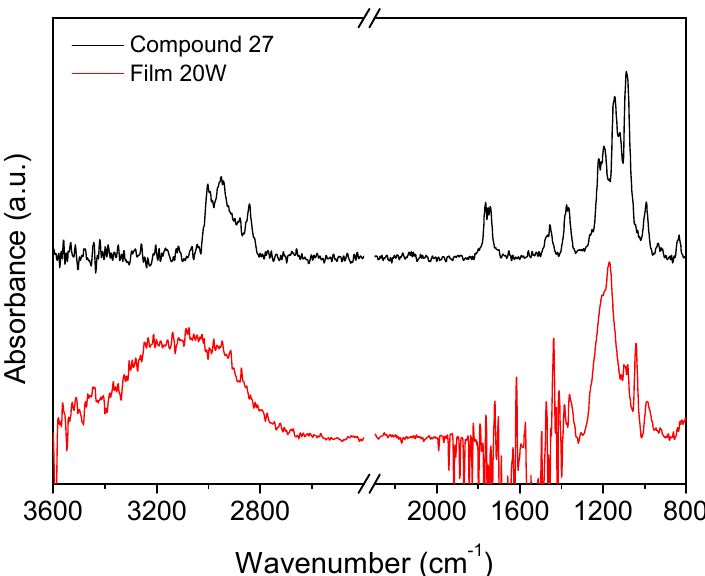
Figure 6. Comparison between infrared spectra of compound 27 vapors and the plasma polymerized film obtained at 20 W.